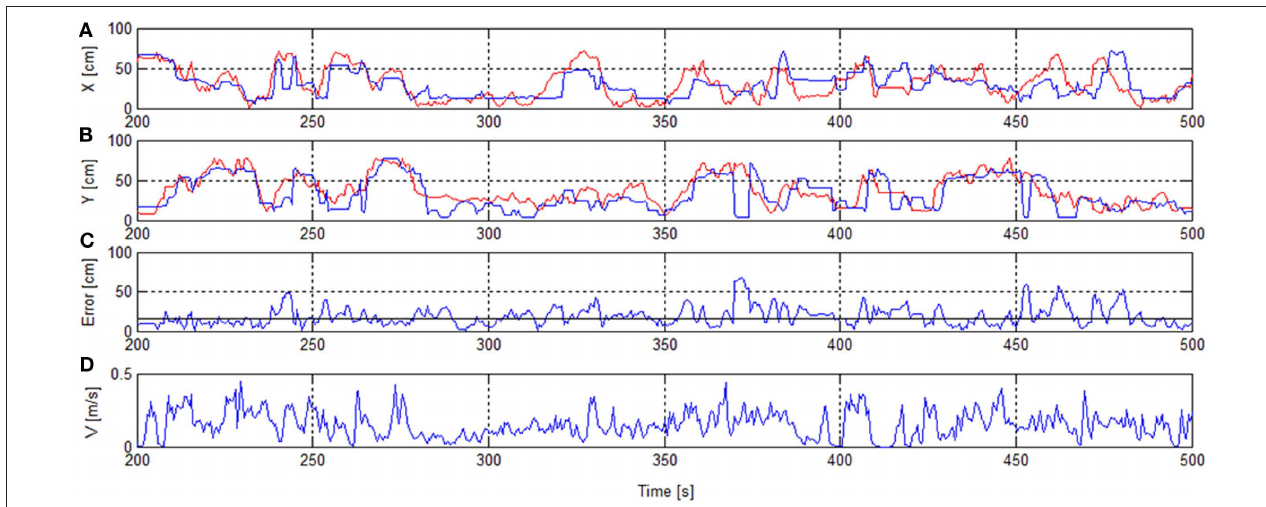
FIgure 4 | rat’s trajectory reconstruction based on place cell firing in real-time mode. x / y -Positions of real track (red) and reconstructed track [blue (A,B) ]. Error with median error horizontal line [solid (C) ]. Speed V (D)